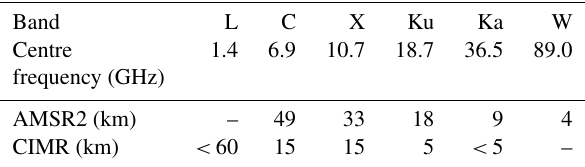
Table 1. Spatial resolution (computed as the arithmetic mean of the minor and major diameters of the instantaneous field-of-view el- lipse) of selected microwave frequencies of the AMSR2 and CIMR missions. AMSR2 also records at 7.3 and a 23.8GHz, and those will not be on board CIMR. The “–” indicates a microwave frequency is not recorded by the mission. The values for CIMR are from Donlon et al. (2020), and those for AMSR2 are from the Observing Systems Capability Analysis and Review (OSCAR) tool of the World Mete- orological Organization. See also Lavergne (2018) for a graphical representation of these